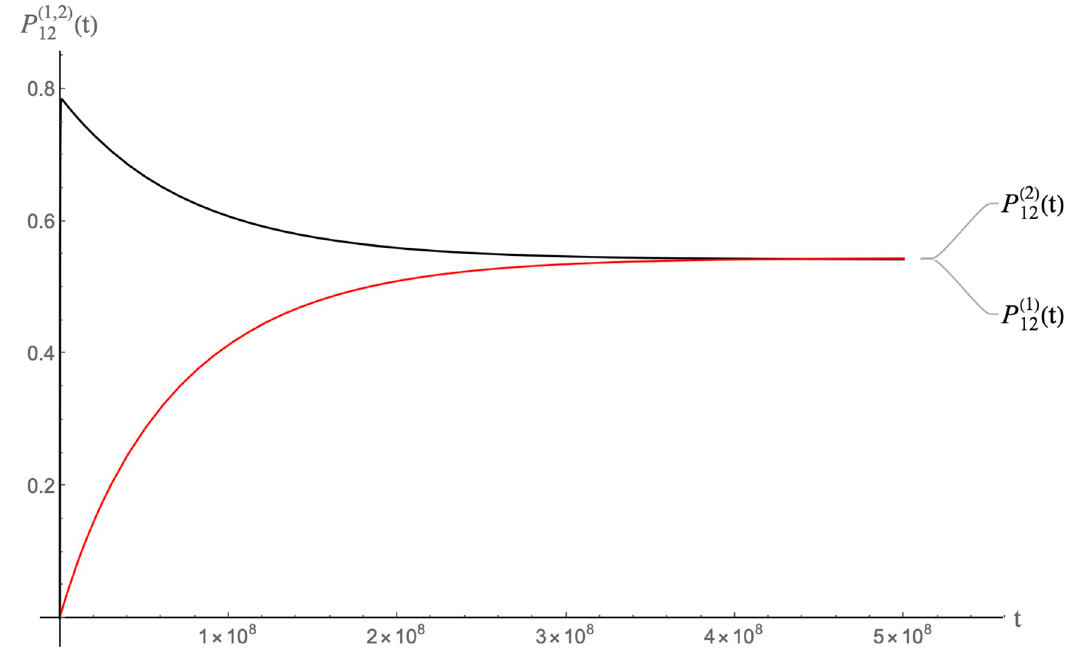
Fig 10. Packaging competition between MLD = 9, N parameters as the previous figure on a time scale of 10 8 units.